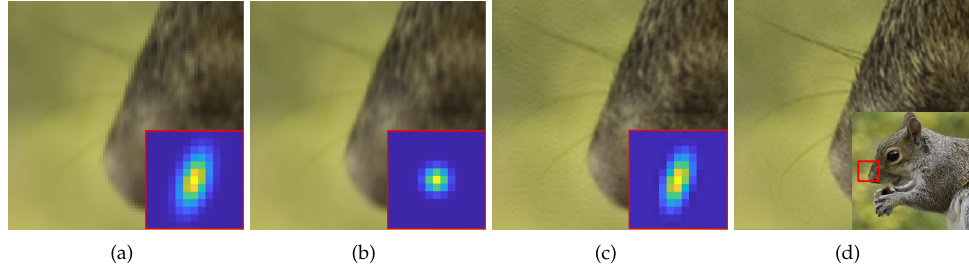
Figure 1. Comparison of SISR results for scale factor of × 2 using [13]. ( a ) input LR image degraded with ground truth(GT) blurring kernel. ( b ) SISR result with a kernel assumed as Gaussian kernel. ( c ) SISR result with an estimated kernel. ( d ) GT